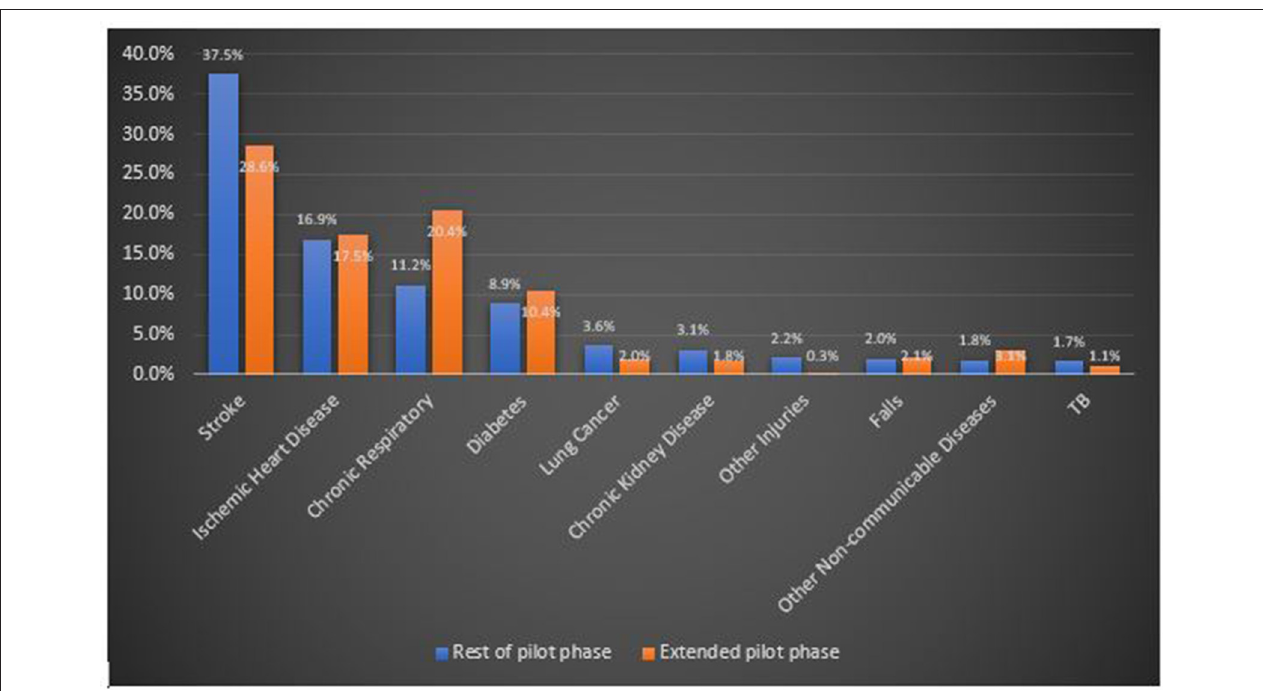
FIGURE 2 | Comparison of the 10 leading causes of death diagnosed by SMARTVA in the Colombo CMC area before and after modification of the terminology used for stroke symptoms.